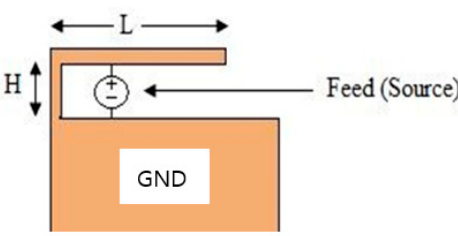
Figure 3. General inverted F antenna (IFA) structure.